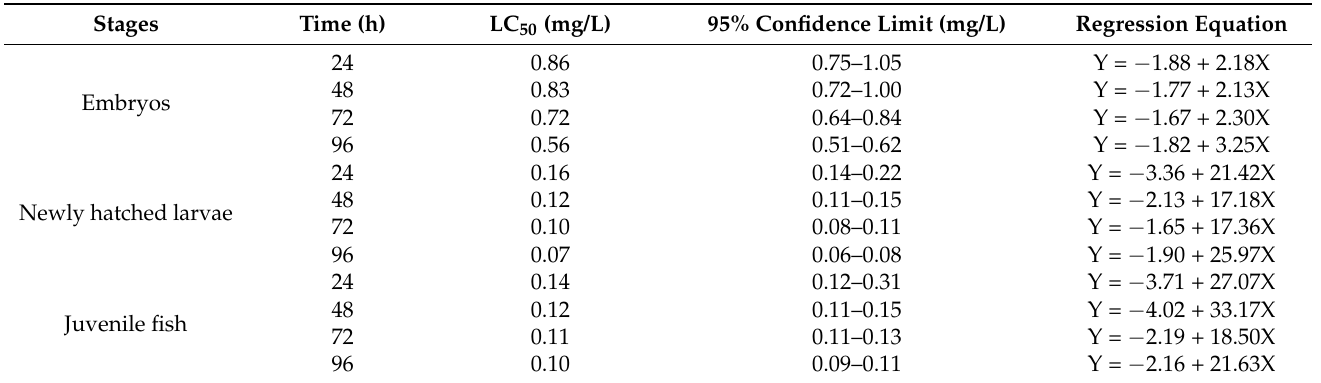
Table 2. Acute toxicity of Hg 2+ to rare minnow at different life